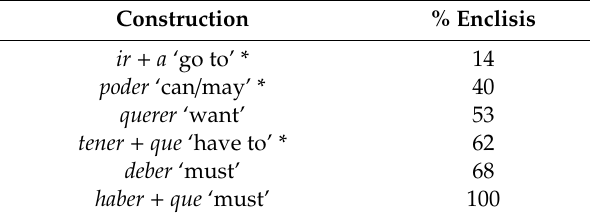
Table 1. Distribution of enclisis in the most frequent constructions in spoken corpora (Davies 1995, p.